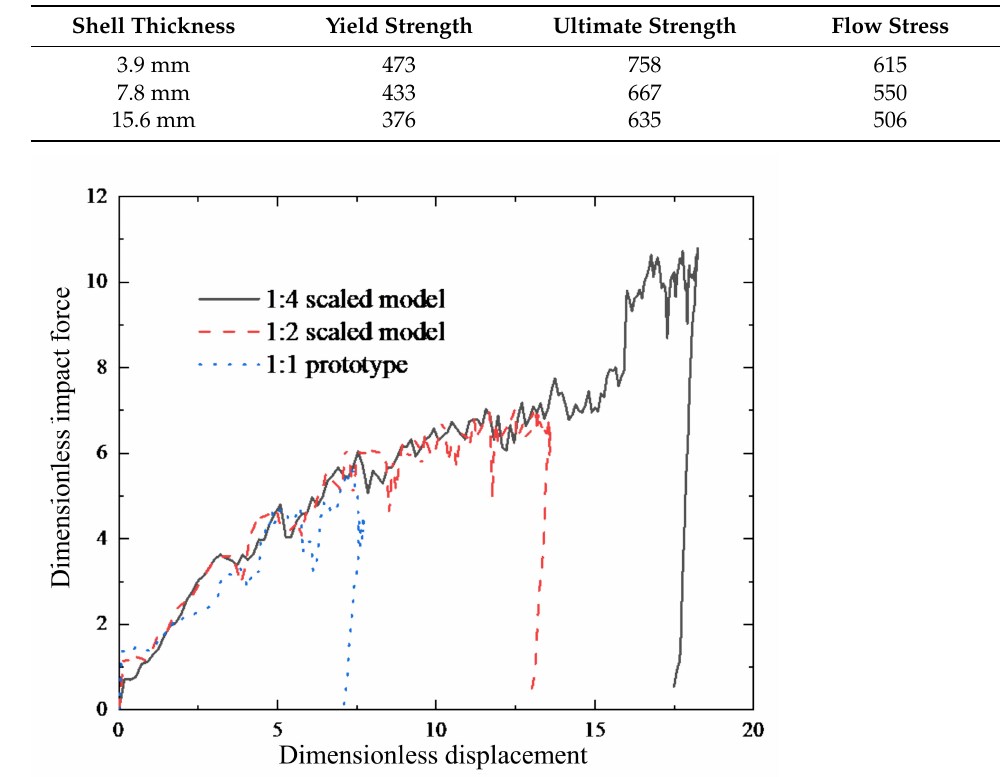
Figure 10. Comparison of impact force-displacement relationships. Table 3. Necessary stress of the materials gained by a tensile test (unit: MPa).